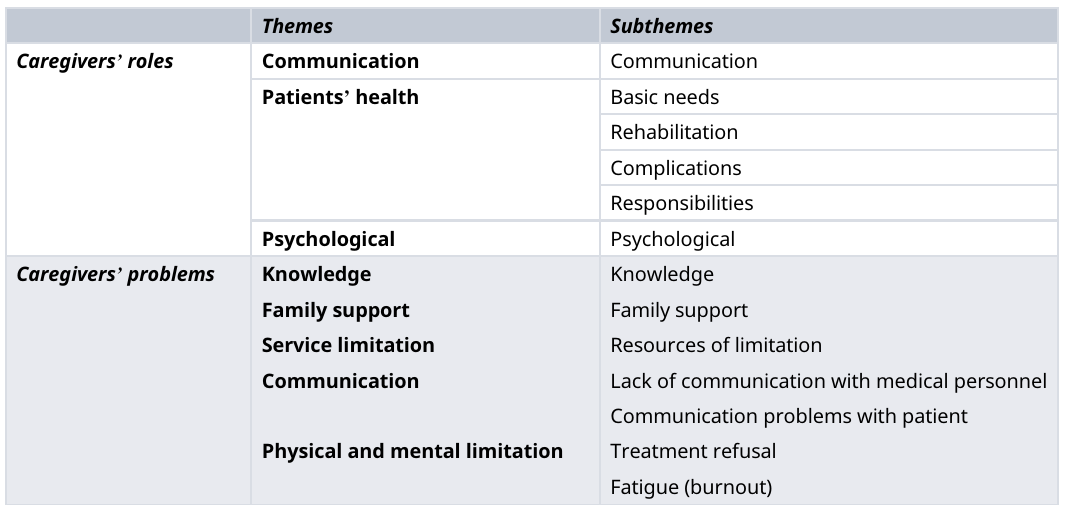
Table 2. Categories and themes of the role and problem of